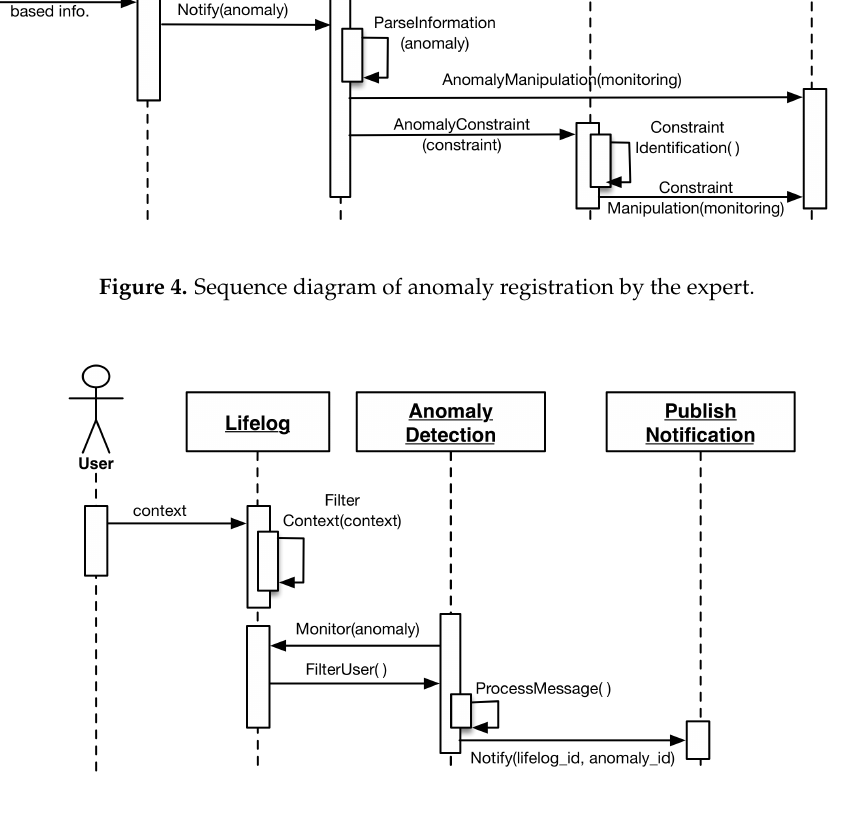
Figure 5. Sequence diagram of message flow in the lifelog